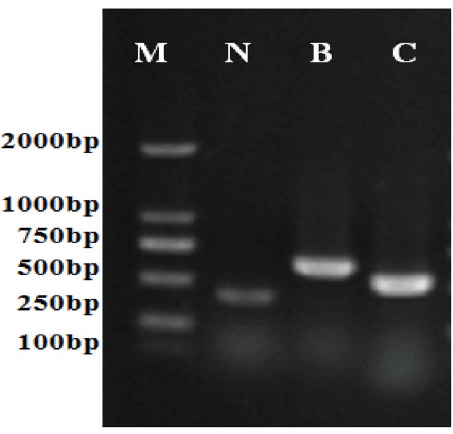
Figure 7. Atrazine-degrading gene amplification of HB-6. Lane 1: DNA marker, lane 2: trzN of HB-6, lane 3: atzB of HB-6, lane 4: atzC